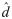
Visualization of the control parameters density d^, balance b^, and symmetry s^ for eight example networks (A-H).Neurons are represented by gray circles, non-zero connections between neurons by arrows. One-headed arrows stand for uni-directional, two-headed arrows for bi-directional connections. Blue/magenta connections are excitatory (wij > 0), red/orange connections inhibitory (wij < 0).